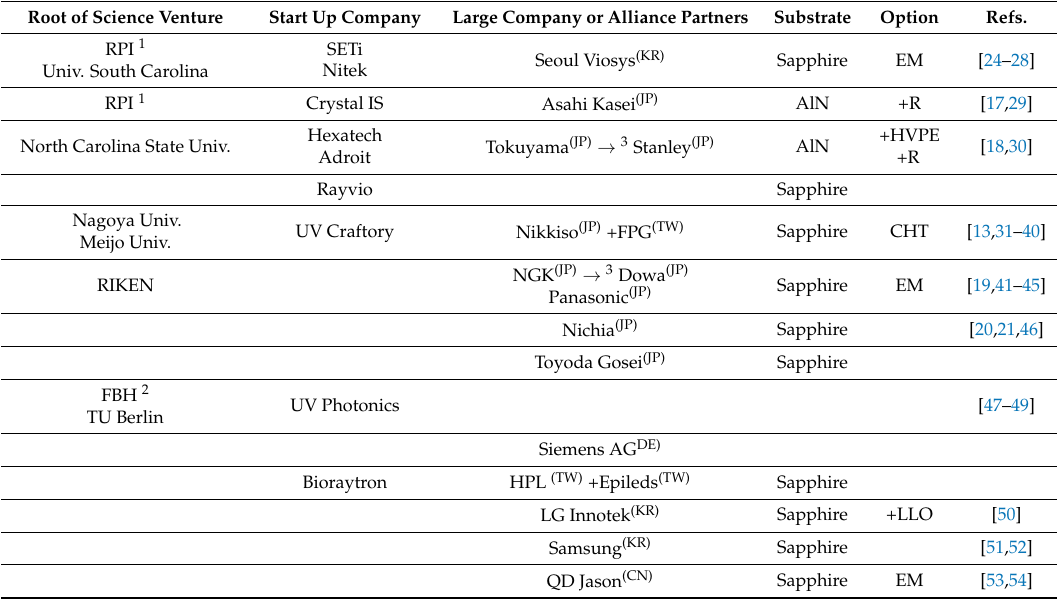
Table 1. List of research, development and manufacturing groups of AlGaN-based DUV-LEDs, indicating the substrate type, the growth technique, and related techniques. EM, enhanced migration; CHT, continuous high-temperature growth by metal organic chemical vapor deposition (MOCVD); +HVPE, halide vapor phase epitaxy. +R and +LLO indicate roughening and laser liftoff, used as additional techniques,